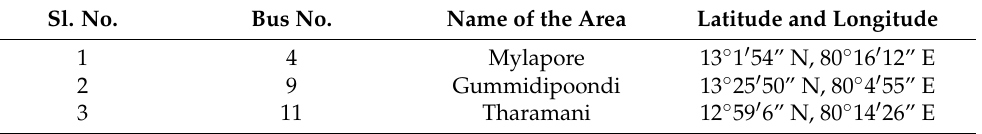
Table 11. Latitude and longitude of the study area. Sl. No. Bus